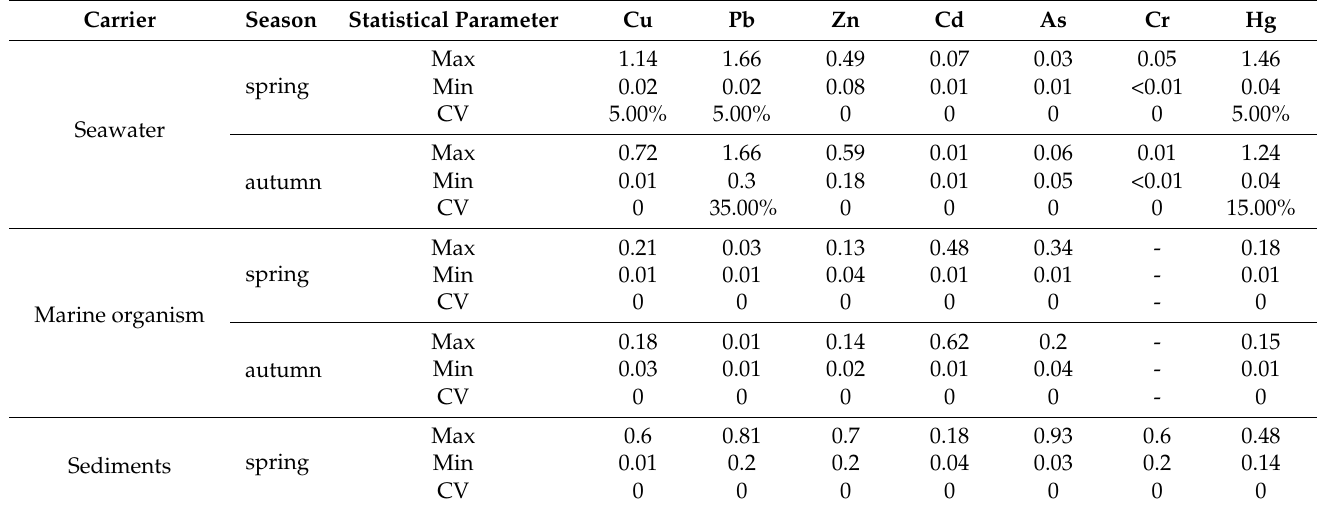
Table 1. Results of standard index